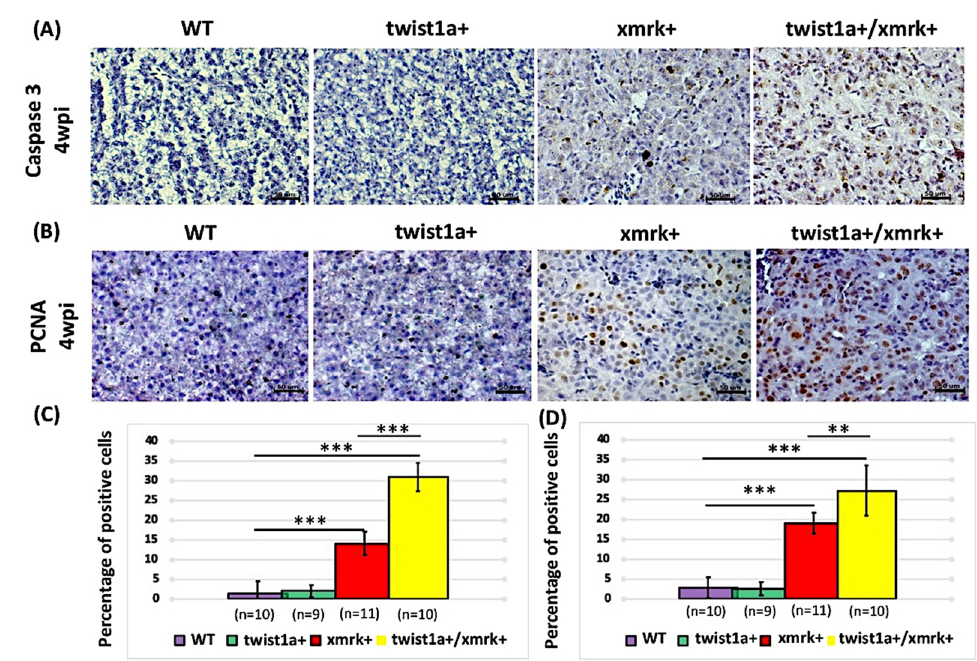
Figure 4. Assessment of apoptosis and cell proliferation in instances of HCC progression in twist1a+/xmrk+ double transgenic zebrafish. Immunohistochemical staining was performed on liver paraffin sections from wild-type, twist1a +, xmrk +, and twist1a+/xmrk+ zebrafish. ( A ) Caspase-3 staining for apoptosis; and ( B ) PCNA staining for proliferation at 4 wpi. Scale bar: 50 µ m. Quantification of the percentage of cells testing positive for ( C ) caspase-3 and ( D ) PCNA. Differences among the variables were assessed using Student’s t -tests. Statistical significance: ** p < 0.01, *** p < 0.001.